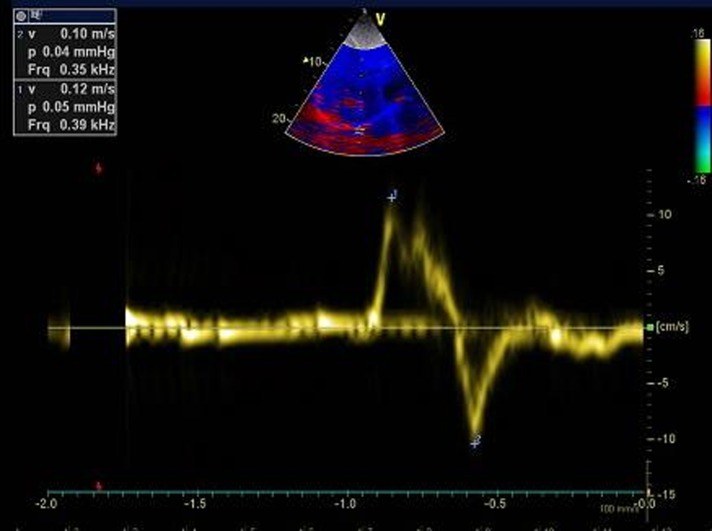
Sniff right hemidiaphragm tissue Doppler imaging peak velocity (arrow) in a volunteer (peak velocity = 12 cm/s).